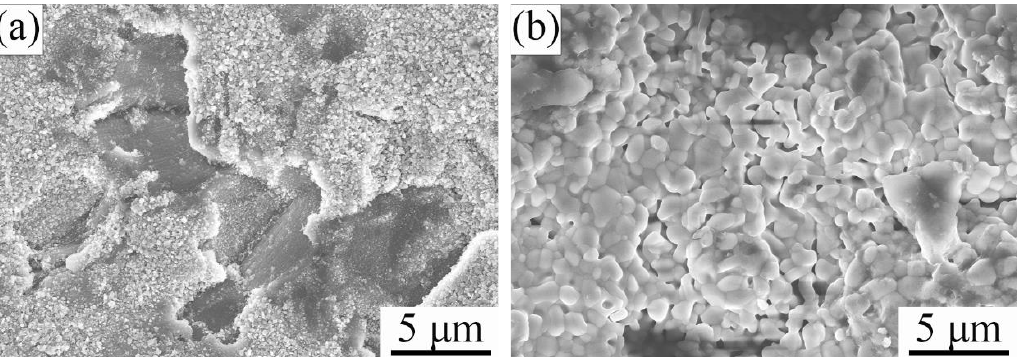
Figure 7. SEM micrographs of sample surface of Ti 2 AlC ceramic quenched in water at different temperatures: ( a ) 920 ◦ C and ( b ) 1150 ◦ C.